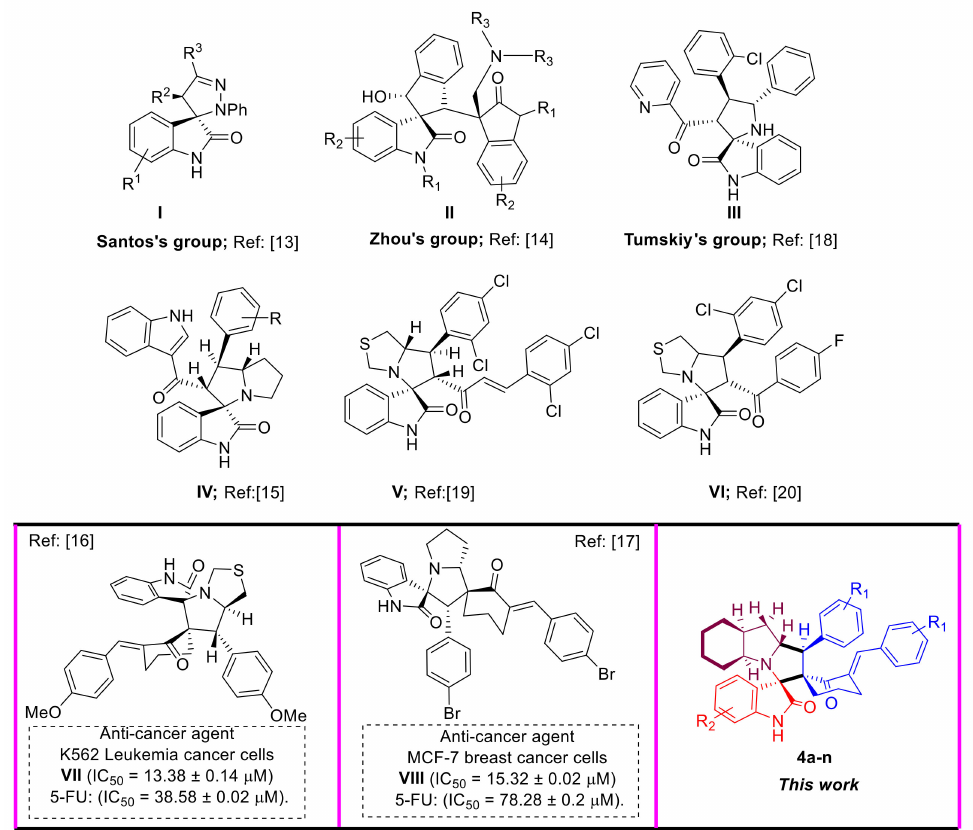
Figure 1. The anticancer activity of some reported spirooxindoles